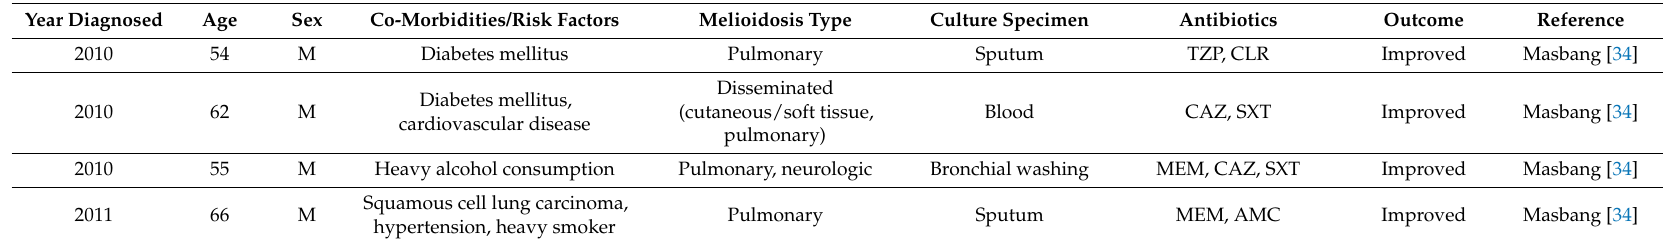
Table 2. Clinical characteristics of confirmed cases of melioidosis in the Philippines from unpublished case reports and